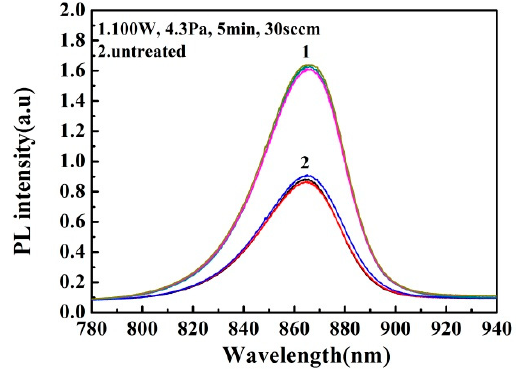
Figure 7. The PL intensity of GaAs samples prepared by an optimized passivation process.